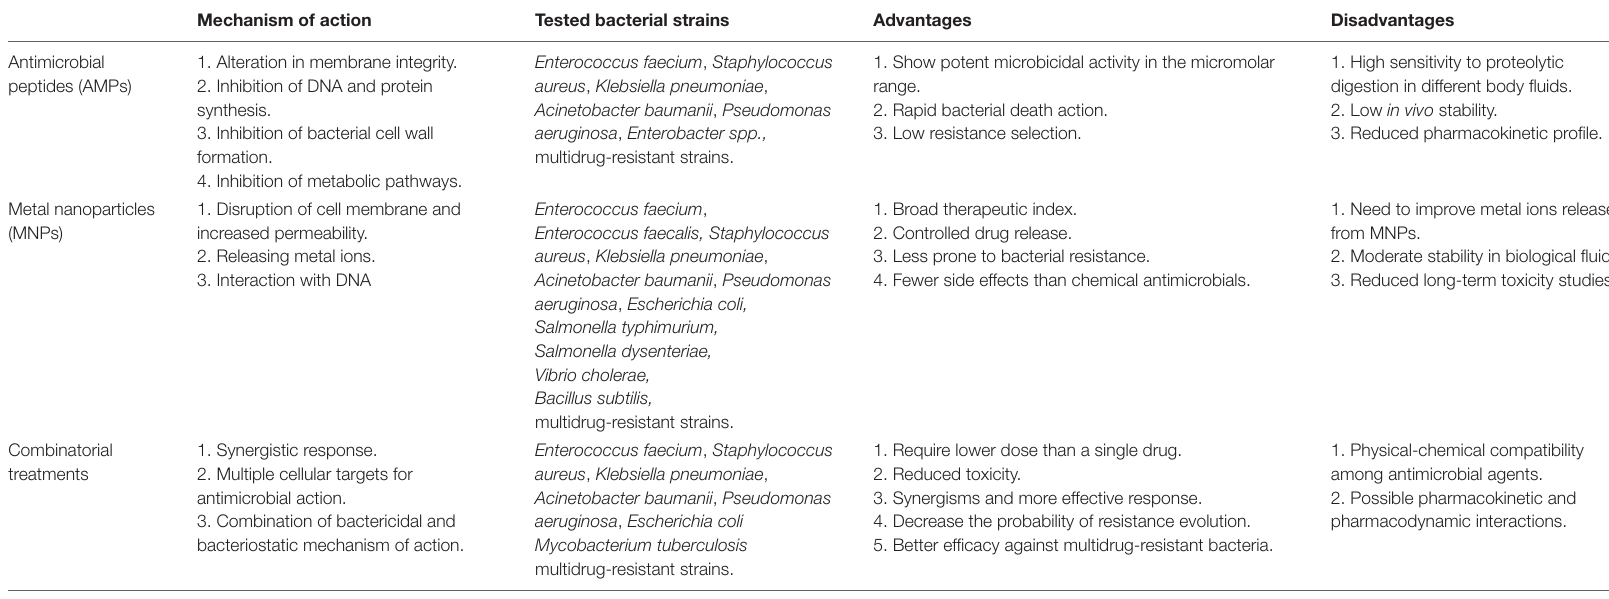
TABLE 1 | Antimicrobial peptides, metal nanoparticles, and combinatorial treatments: mechanism of action, tested bacterial strains, advantages, and disadvantages. Mechanism of action Tested bacterial strains Advantages Disadvantages Antimicrobial peptides